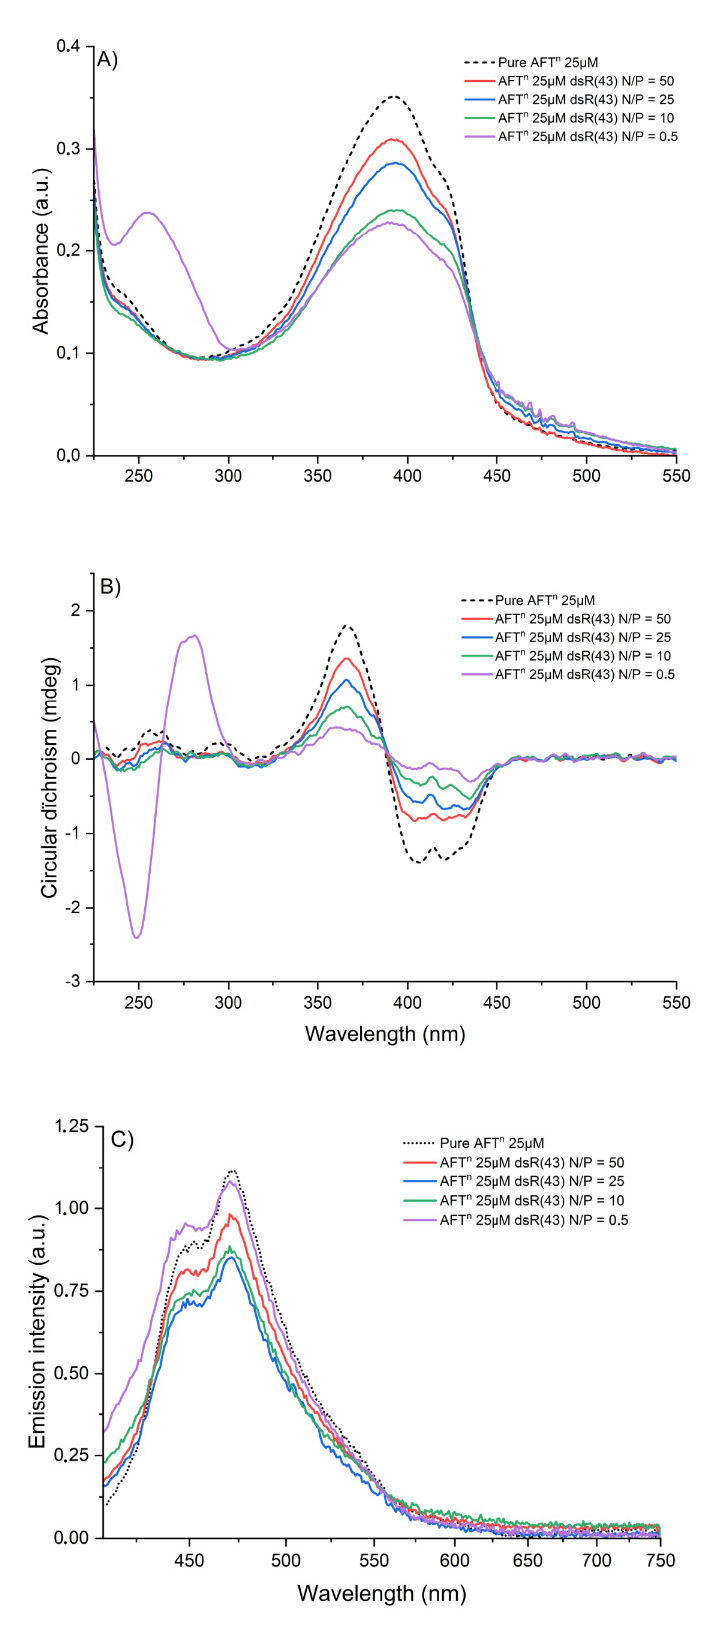
Figure 4. UV-Vis absorption ( A ), CD ( B ) and emission ( C ) spectra of 25 µ M AFT n solutions in TE buffer (pH 7.4) upon addition of dsR(43) DNA.